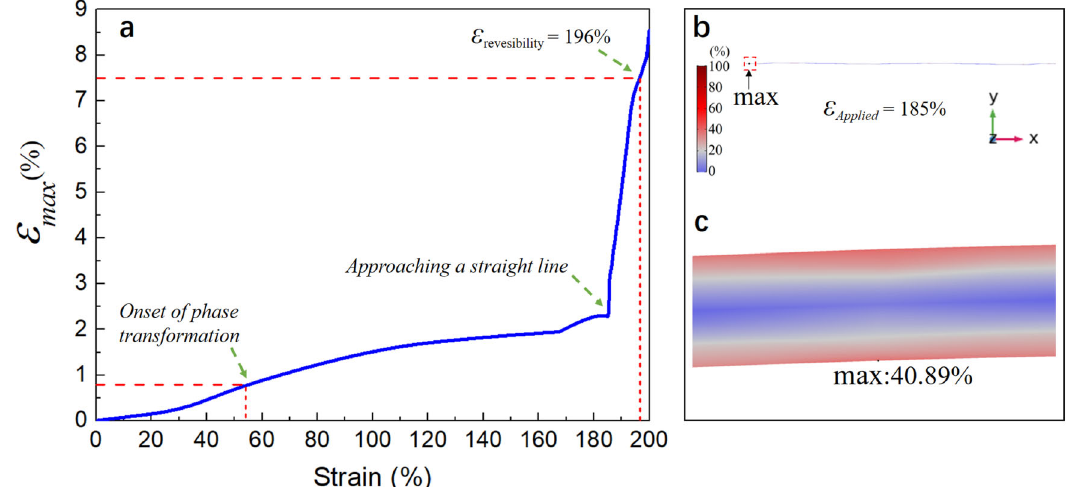
Fig. 5 Discussion of FEA simulation results. a Dependence of the maximum principal strain, ε max , (on the material level) on the applied strain, ε app , (on the structure level). b FEA simulation of the martensite volume fraction distribution under the applied tensile strain of 185%. c Magni fi ed view of modeling results for the part of the interconnect structures that experience the highest